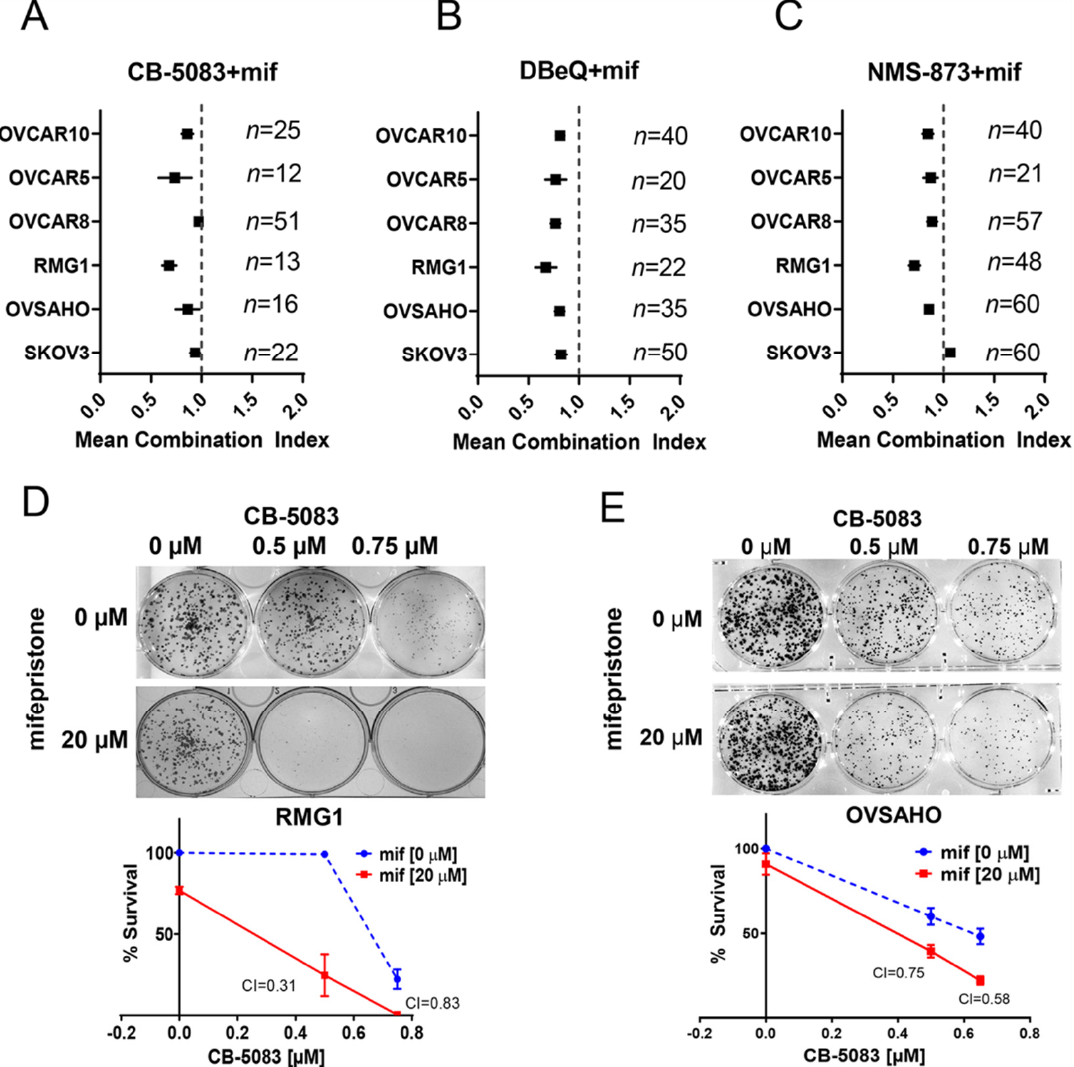
Figure 2. Mifepristone produces synergistic cytotoxicity with VCP inhibitors. ( A ): High-grade serous ovarian cancer cell lines OVCAR10, OVCAR5, OVCAR8, and OVSAHO as well as clear cell ovarian cancer cell lines RMG1 and SKOV3 were treated with different combinations of mifepristone (between 5 and 20 µ M) and CB-5083 (between 0.25 and 1 µ M). Combination indexes (CIs) were calculated at all such combinations that yielded an effect between 20 and 80% cytotoxicity. Each data point is shown as the mean CI of all calculated combinations and 95% confidence interval. “ n ” represents the total number of CIs calculated from the combinations that produced the combined effect of 20–80% cytotoxicity from three biological replicates. Mean combination index (CI) less than 1 indicates synergy. ( B ): Same as ( A ) but treated with different combinations of mifepristone (between 5 and 20 µ M) and DBeQ (between 1 and 7.5 µ M). ( C ): Same as ( A ) but treated with different combinations of mifepristone (between 5 and 20 µ M) and NMS-873 (between 1 and 2.5 µ M). ( D ): RMG1 cells were treated with the indicated concentrations of CB-5083 and mifepristone for 48 h followed by 6–8 days of recovery in regular medium. Mean percent survival ± SEM was calculated based on the number of colonies from three biological replicates. ( E ): Same as ( D ) but in OVSAHO cells. Percent survival was calculated based on the number of colonies from three biological